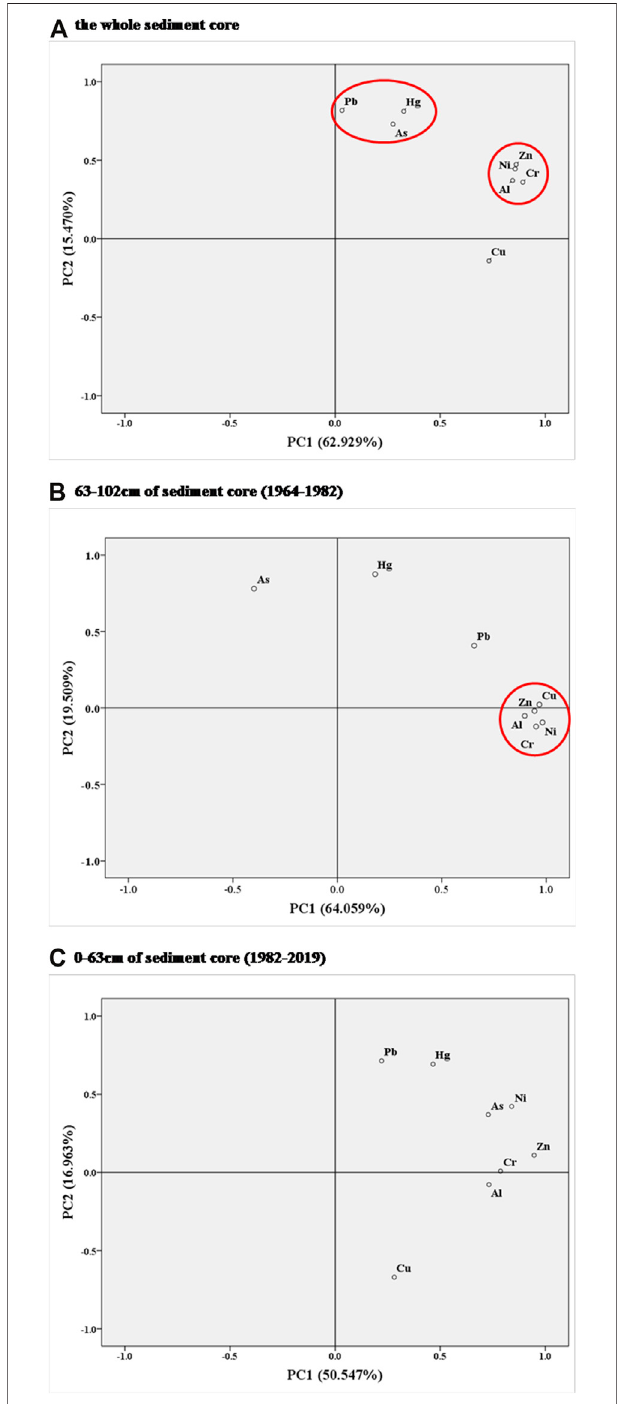
FIGURE6| Plots of loadingsofPC1 and PC2 from principal component analysis (PCA) of sediment core SKL8-2 from Songkhla Lake. (A) The whole sediment core; (B) 63 – 102cmofsedimentcore (1964 – 1982); (C) 0 – 63cmof sediment core (1982 – 2019).